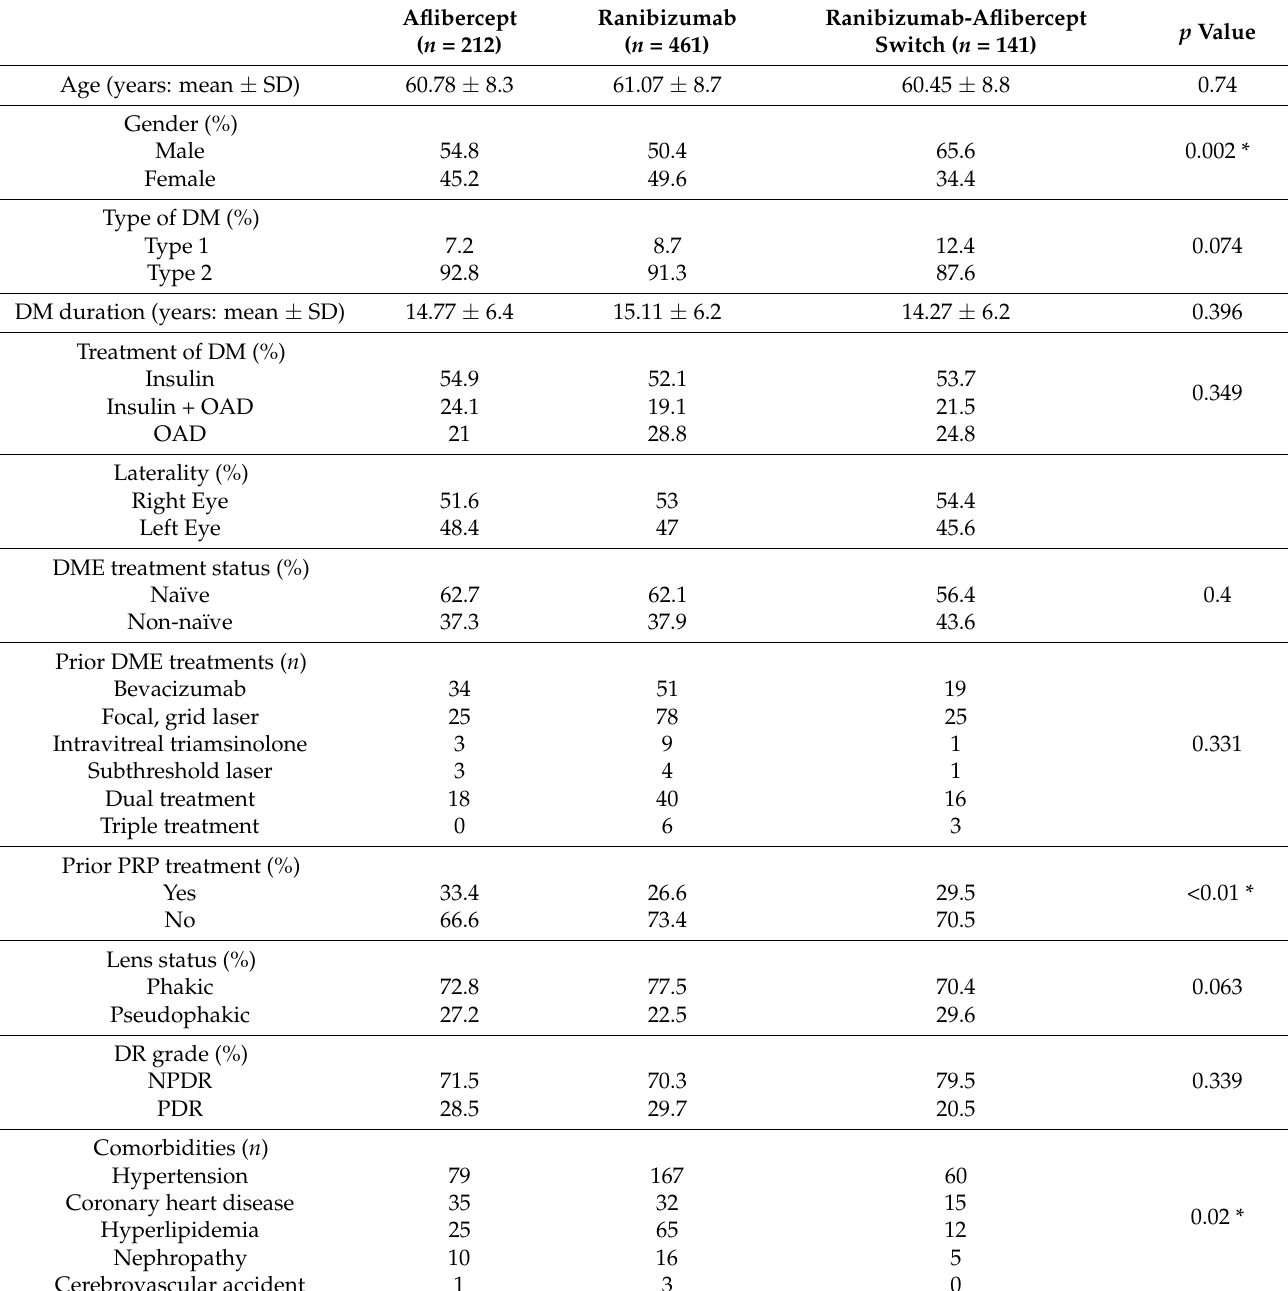
Table 1. Baseline characteristics of the study